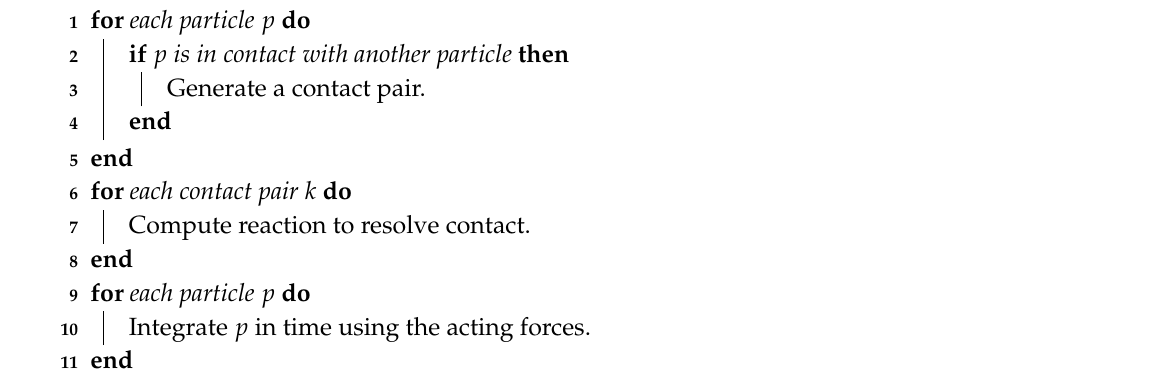
Algorithm 7: Pseudocode for rigid body